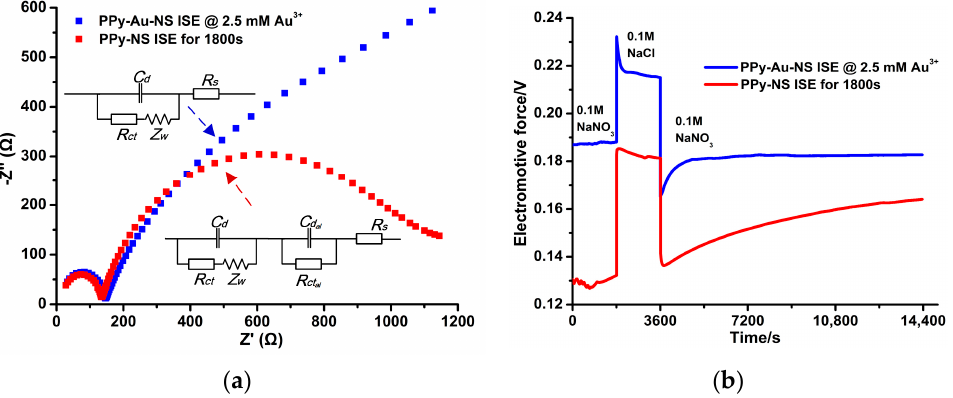
Figure 12. EIS with the equivalent circuit of PPy Au-NS ISE ( a ) and aqueous layer tests ( b ) of the PPy-NS ISE and PPy-Au-NS ISE in 0.1 M NaNO 3 solution.